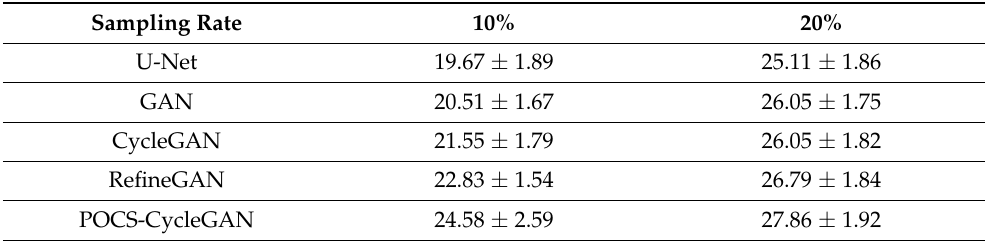
Table 1. PSNR (mean standard deviation) of different methods with different sampling rates for the NYU dataset.